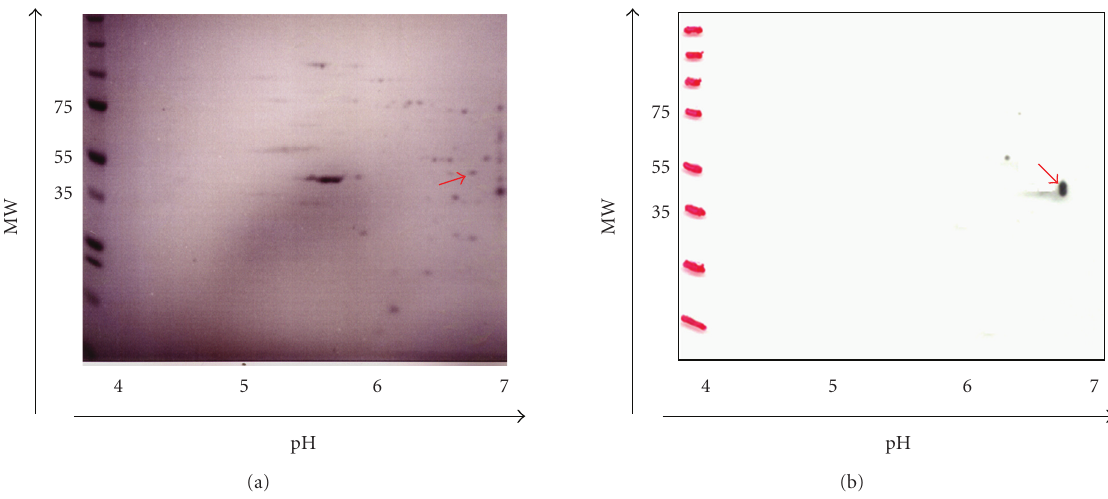
Figure 6: ERK-like detection by 2DE and protein sequencing. Total protein of in vitro cultured T. crassiceps was resolved in a double dimension gel (a). A well-defined dot ( ∼ 55 KDa, pH = 6.8) was detected in T. crassiceps and then purified from the gel for sequencing (b). MW = Molecular weight